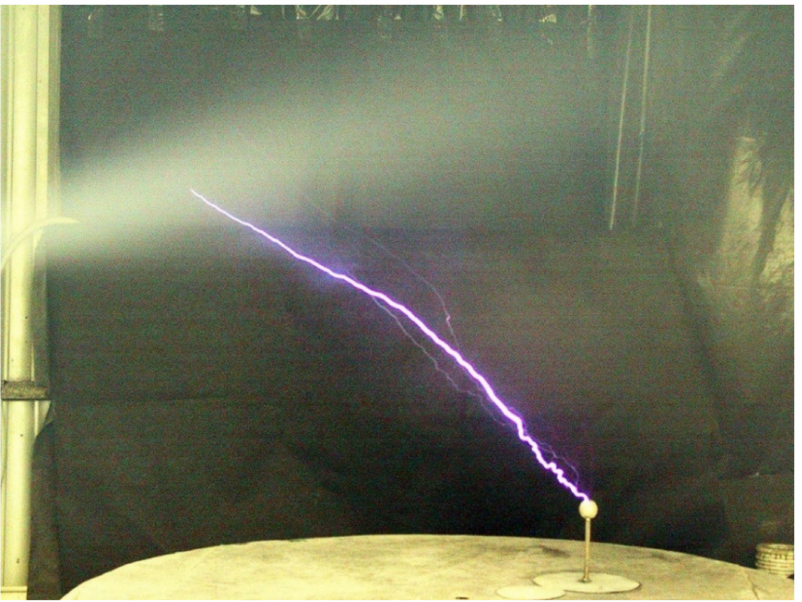
Figure 1. Characteristic picture of the discharge formation between artificial thunderstorm cell of negative polarity and the